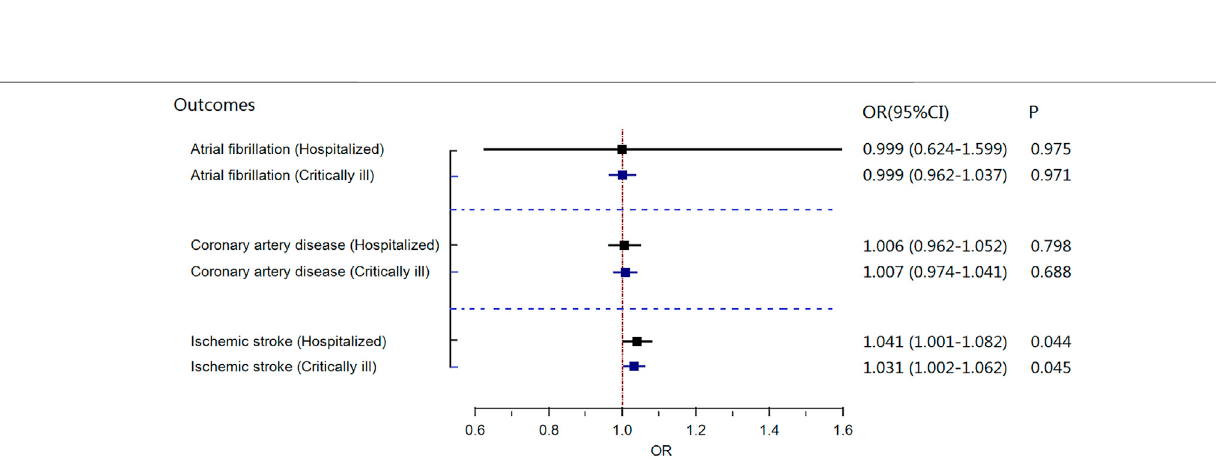
FIGURE2| Resultsoftherandom-effectsMRIVWmodelinvestigatingthecausalassociationofgene-predictedseverecoronavirusdisease2019(COVID-19)and risk of three cardiovascular diseases in COVID-19 GWAS data (without UKBB data). CI, con fi dence interval; OR, odds ratio; MR, Mendelian randomization; COVID-19, severe coronavirus disease